Question: Produce a descriptive caption suitable for publication.
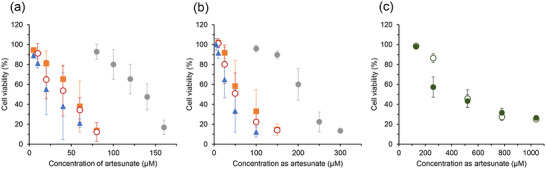
Answer: Cell viability of HepG2 treated with artesunate (a), PSBMA‐ARTs conjugates (b), and cell viability of primary human hepatocytes treated with artesunate or PSBMA‐ARTs conjugates (c). The grey circles show the cell viability treated with artesunate or PSBMA‐ARTs conjugates individually. The red‐bordered circles indicate the cell viability when each drug was individually administered to cells pretreated with Fe 2 + . Triangles and squares show the cell viability administered artesunate or PSBMA‐ARTs conjugates with Fe 2 + or Fe 3 + simultaneously. The closed and open circles in (c) represent artesunate and PSBMA‐ARTs conjugates, respectively. Both data are shown as the mean ± SD ( n = 10). Statistical significance was measured between two groups using unequal variances Welch's t‐test.